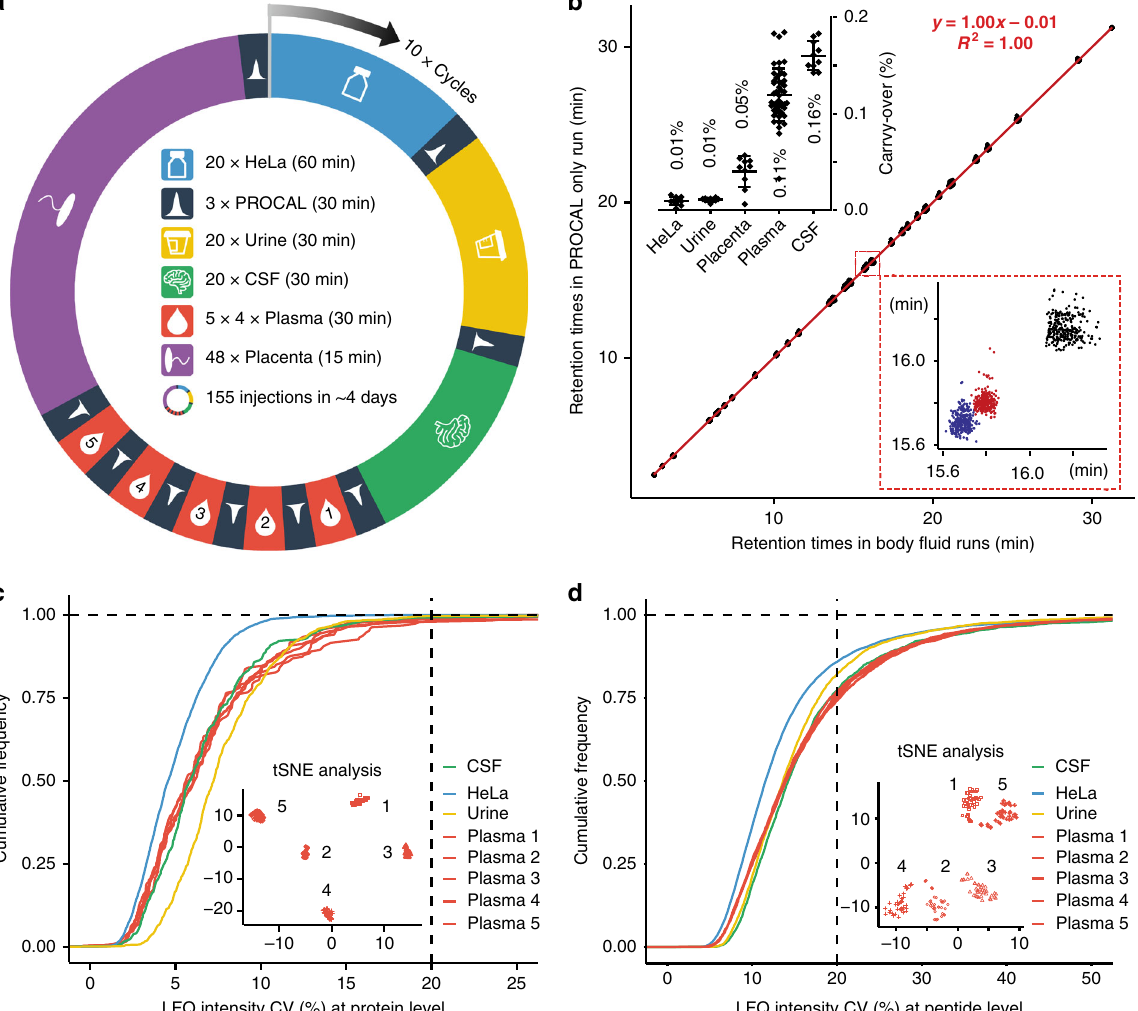
Fig. 3 Quantitative performance characteristics of the micro- fl ow LC – MS/MS system. a Design of a long-term performance test consisting of 10 cycles of 155 injections each. In each cycle, 20 replicates of 2 µ g HeLa, 5 µ g urine, 5 µ g cerebrospinal fl uid (CSF), and 5 µ g each of 4 replicates of plasma digests from fi ve individuals, as well as one deep-scale placenta digest (200 µ g protein digest separted into 48 fractions) were analyzed using micro- fl ow LC – MS/ MS using the stated gradient times. Between each sample type, 3 replicates of 500 fmol PROCAL synthetic retention time standards were injected. b Retention time stability of PROCAL peptides measured alone or spiked into body fl uids (urine, CSF, plasma samples; main plot). The equation represents the linear model that was fi tted to the data ( R 2 , squared Pearson correlation coef fi cient). The bottom right inset shows an expanded view of the main plot showing the retention time distribution of three closely eluting PROCAL peptides (in different colors) across all experiments. The top left inset summarizes the carry-over analysis across all 10 cycles (columns denote average carry-over and error bars denote the standard deviation). Source data are provided as a Source Data fi le. c Cumulative density plot showing the inter-cycle reproducibility of protein quanti fi cation for 200 injections of HeLa, urine and CSF, and 40 injections of fi ve individual plasma samples (common proteins only). Dotted lines denotes the percentage of proteins that show <20% coef fi cient of variation (CV) in the analysis The inset shows a t ‐ SNE analysis of the 40 plasma injections measured from each of fi ve individuals across the 10 cycles. d Same as in c but at the peptide